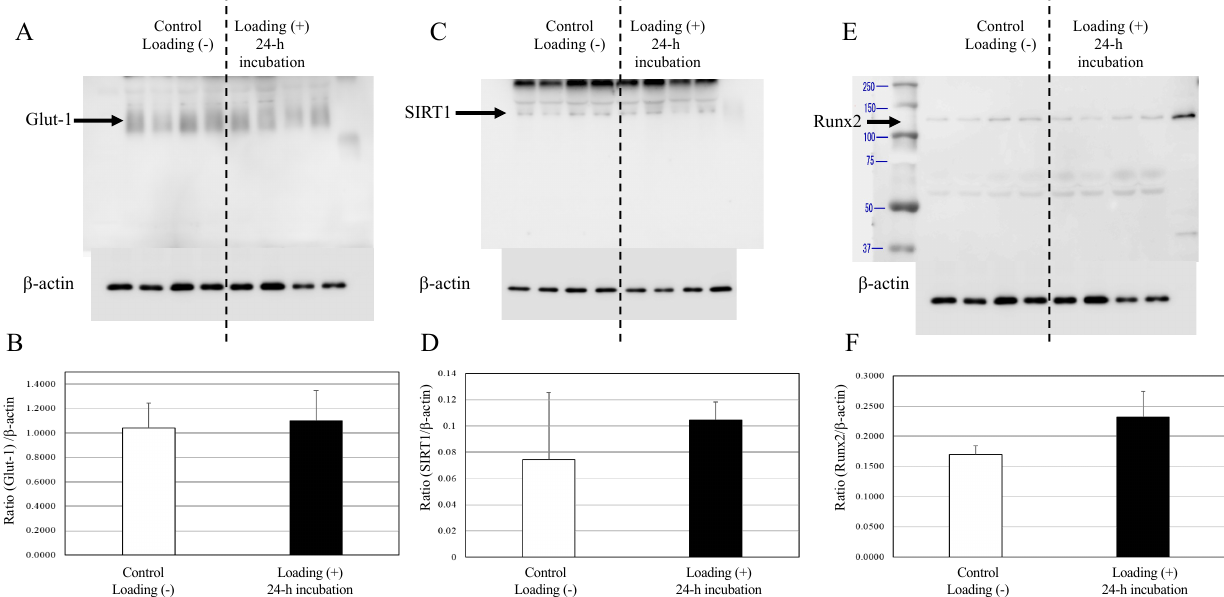
Loading (+) incubationControl 24-h Loading (-) Figure 6. Expressions of Glut1, SIRT1, and Runx2 in chondrocytes. The expression of Glut1s ( A ), SIRT1 ( C ), and Runx2 ( E ) in chondrocytes were not affected by loading (Western blot). ( B , D , F ) The expressions relative to the levels of β -actin. (each subgroup/time point, n = 12 × three independent